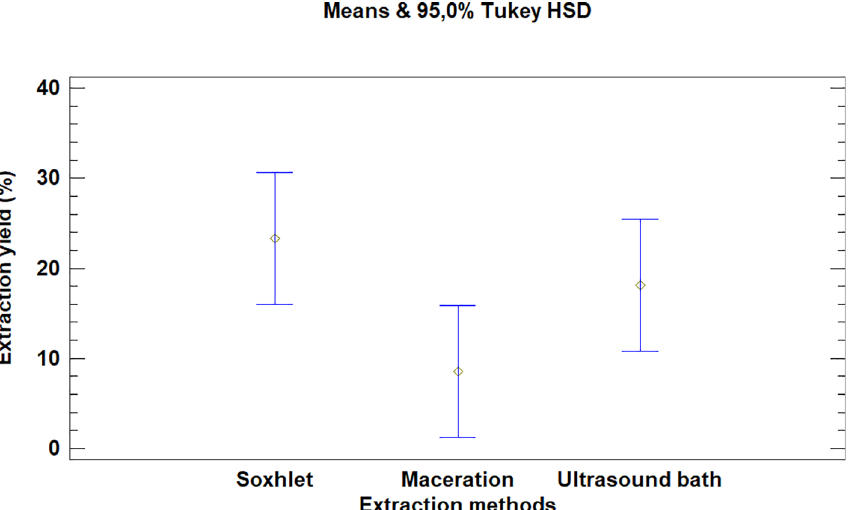
Figure 7. Comparison of Tukey means for yields of Croton floccosus extracts according to the extraction Table 4 details the qualitative results of the phytochemical tests performed on the ethanolic extracts of Bidens pilosa L. (Asteraceae) and Croton floccosus (Euphorbiaceae), obtained with Soxhlet extraction. There is a low presence of flavonoids and saponins, and a relatively abundant presence of phenols and tannins for both species. In addition, a relatively abundant presence of alkaloids is detected for the species Croton floccosus and no reducing sugars are detected, while a low presence of reducing sugars is detected for the species Bidens pilosa L.